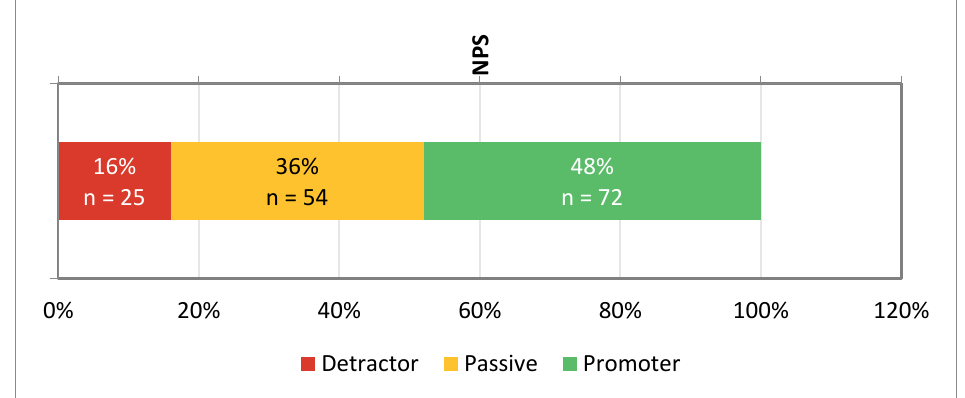
Figure 14. Recommendation to move to a timber-framed apartment.